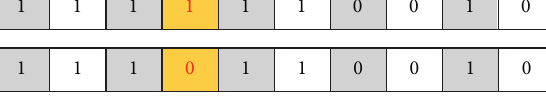
Figure 4: Mutation